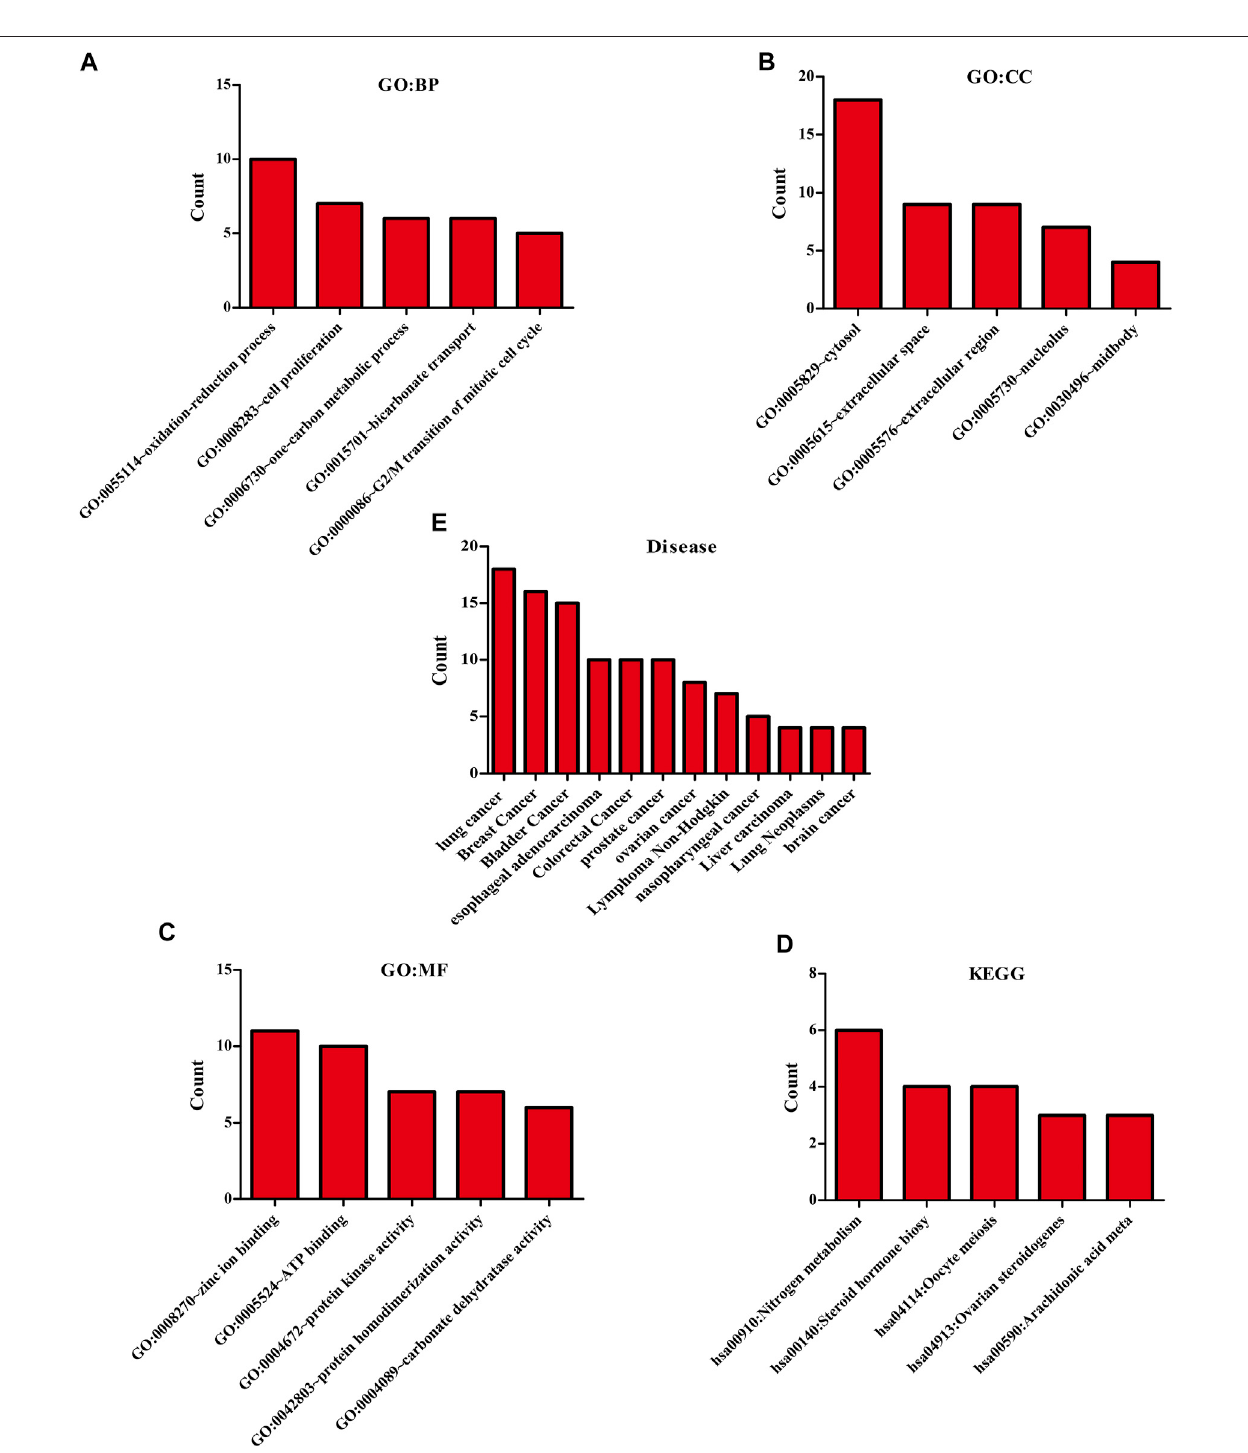
FIGURE2| Thebiologicalfunctions,mechanismsanddiseasesof40quercetin-relateddifferentiallyexpressedtargetgeneswereexploredintheDAVIDdatabase.